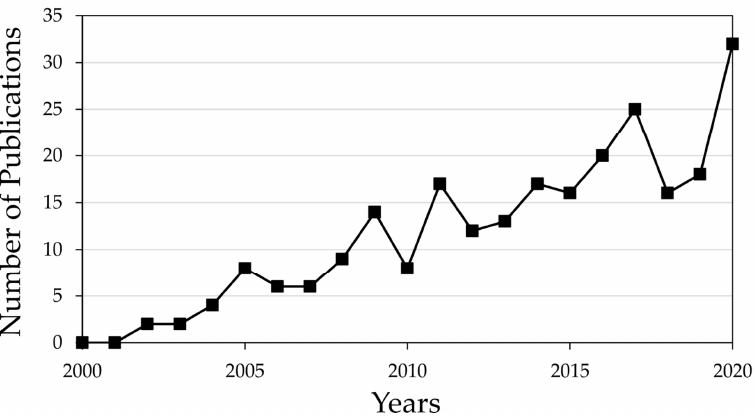
Figure 1. Number of published research articles on Harmful Algal Blooms (HABs) in the Mediterranean coastal areas during the period 2002–2020. No research articles were retrieved for the years 2000 and 2001. The Mediterranean Sea (MS) is a large, enclosed sea that lies between Europe, Asia, and Africa. The MS is linked with the Atlantic Ocean through the Strait of Gibraltar in the west, is connected to the Red Sea by the Suez Canal in the southeast, and is also linked with the Black Sea in the northeast through the Strait of Gallipoli-Bosporus [35]. It covers an area of 25,000,000 km 2 , equivalent to 1% of the Earth’s surface, and includes ten differ- ent rather isolated sub-basins, which are: (1) Alboran Sea, (2) northwestern basin, (3) southwestern basin, (4) Tyrrhenian Sea, (5) Adriatic Sea (northern, central and southern), (6) Ionian Sea, (7) Central basin, (8) Aegean Sea (northern and southern), (9) North Levant Sea, and (10) south Levant Sea [36–38]. It represents a unique marine environment regard- ing its geomorphological, climatic, hydrological conditions, and biodiversity status. It is generally characterized by limiting nutrient conditions (especially due to low Phosphorus concentrations) which lead to low phytoplankton biomass and primary productivity. This oligotrophic complexion of MS increases from west to east and from north to south [39]. However, the coastal areas of MS are inhabited by many people with a coastal population density of 58.5 inhabitants per km 2 land area; the human population in these areas is ex- pected to grow further in the following years and is projected to reach 200,000,000 inhab- itants in 2025–2030 [40–42]. Thus, coastal areas of the MS are under numerous environ- mental pressures arising mainly from human activities. Drivers of marine ecosystem de- struction and degradation include agriculture, aquaculture, animal farming, tourism and other economic activities, and discharge of untreated urban and industrial wastewaters. Following the increase of population in Mediterranean countries, anthropogenic activities increase the supply of nutrient inputs, which puts coastal zones under the threat of eu- trophication [43,44]. According to a study based on the Geospatial Regression Equation for European Nutrient losses model (GREEN), during 2003–2007, 1.87 t year − 1 of total ni- trogen (TN), and 0.11 t year − 1 of total phosphorus (TP) were discharged in the MS, whereas the Nile, Po, Rhone, Ebro, and northern Greece’s rivers were the main suppliers of nutri- ent discharge. Furthermore, the study showed that the main contributor of TN is agricul- ture and that of TP is wastewater [43]. The nutrient-rich coastal areas represent an advan- tageous environment in which many algal species with harmful impacts might prevail